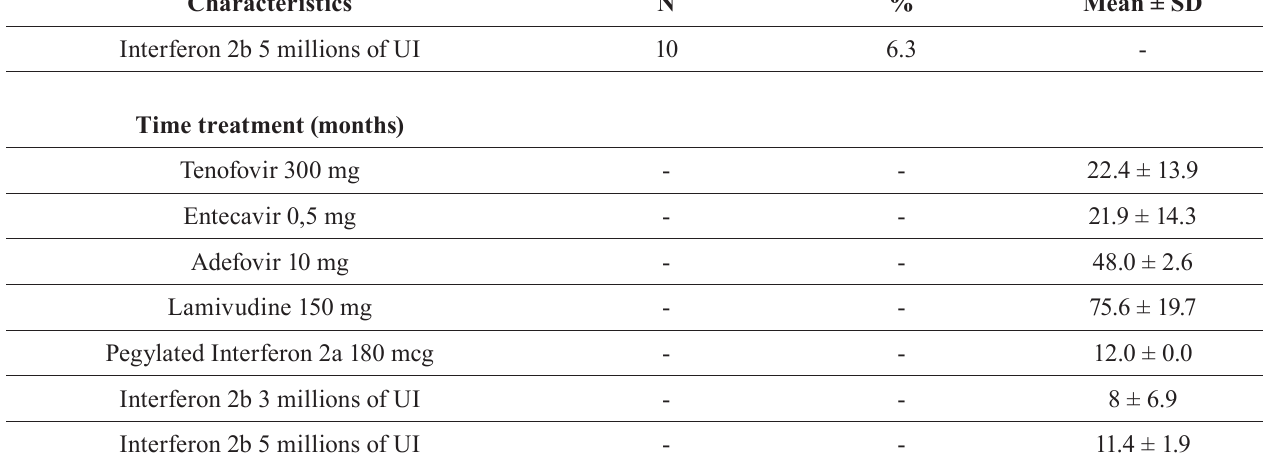
TABLE IV - Sociodemographic characteristics of the participants in the evaluation of quality of life in the city of Cascavel – PR